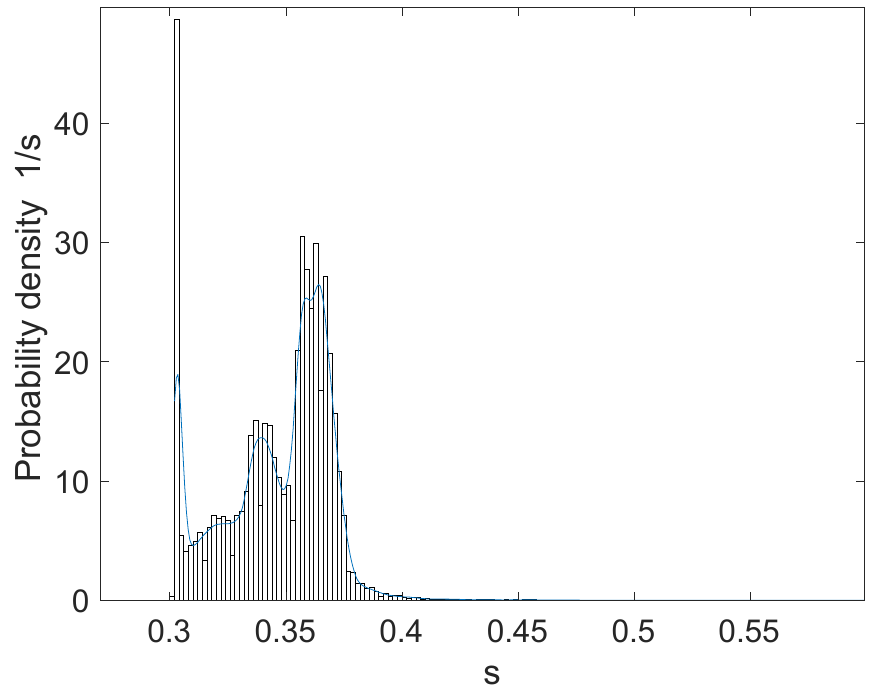
Figure 9. The empirical probability density function of the cycle time of the Z component. The solid line shows the smoothed approximation of the distribution.